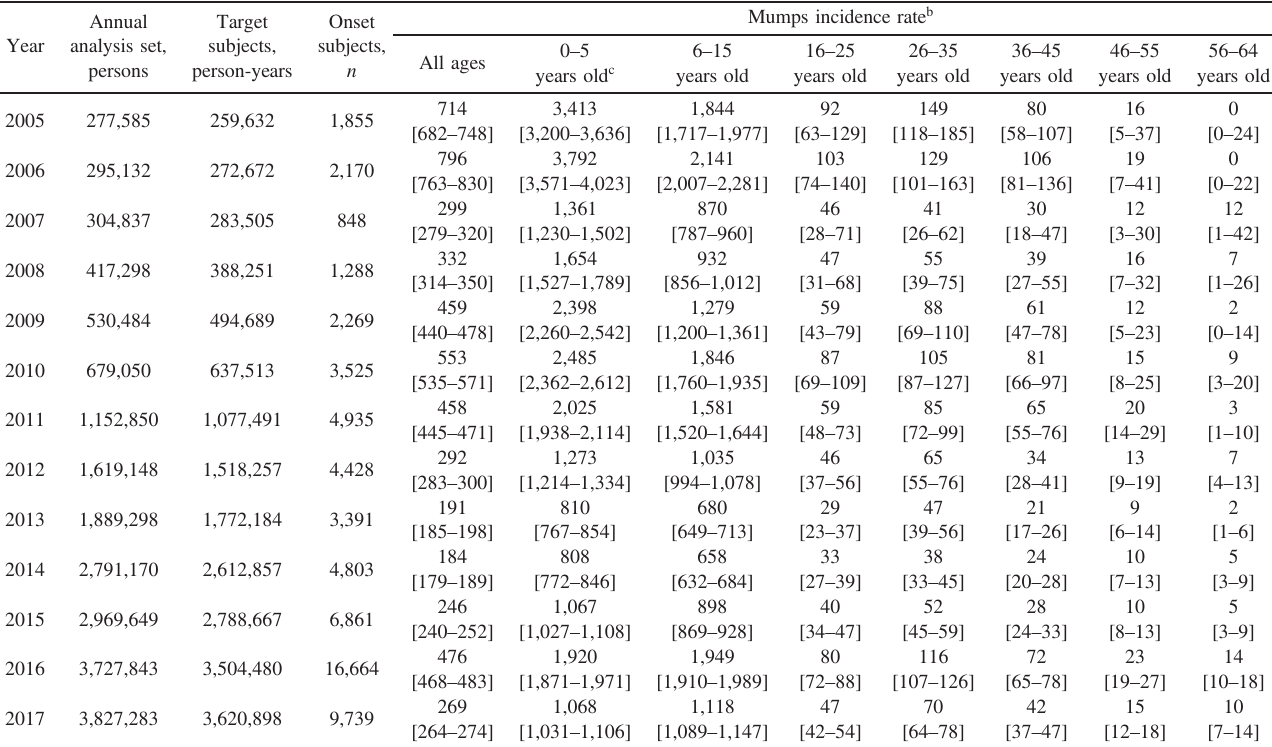
Table 1. Annual mumps incidence rates [95% CI] in males and females aged 0 – 64 years according to age group, based on the